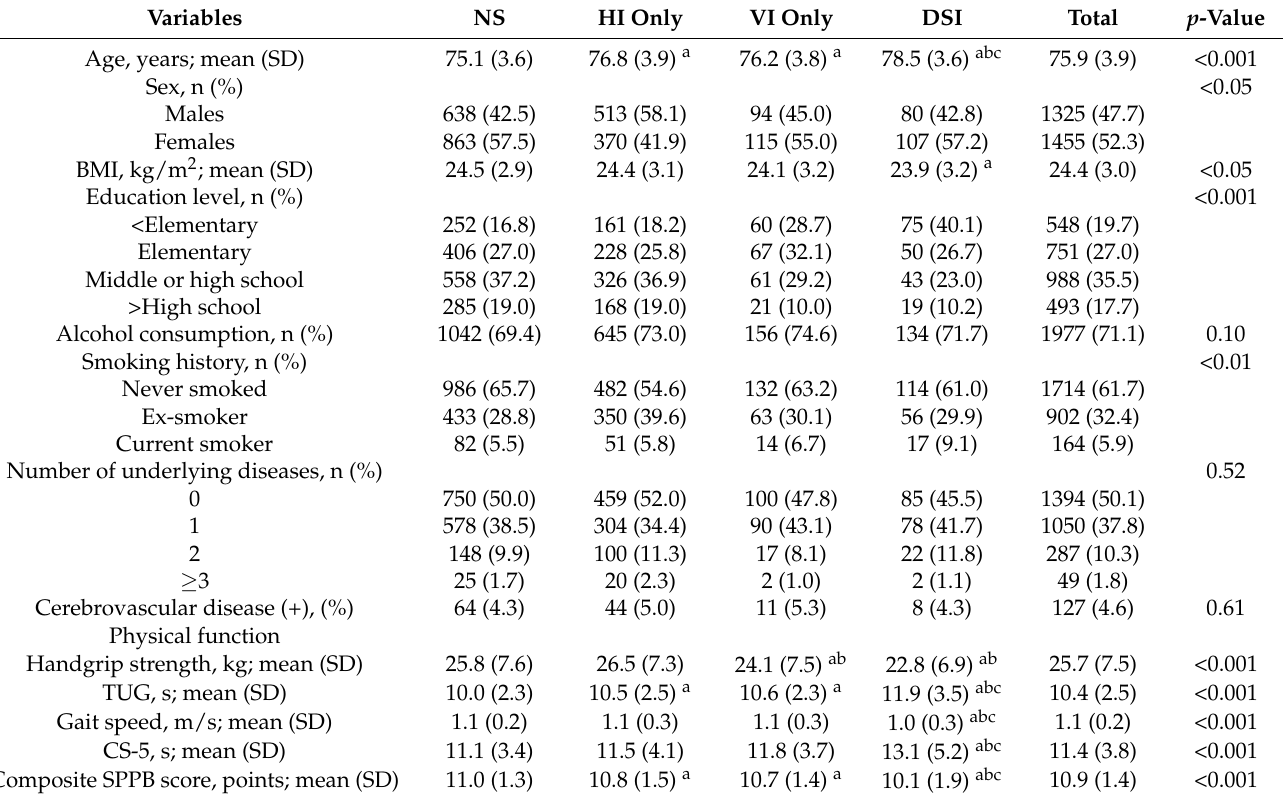
Table 1. Characteristics and physical functions of the participants according to sensory